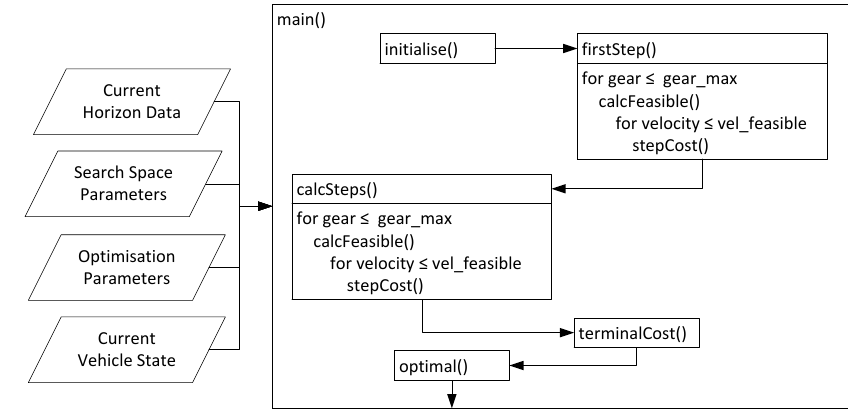
Figure 5. Dynamic programming software